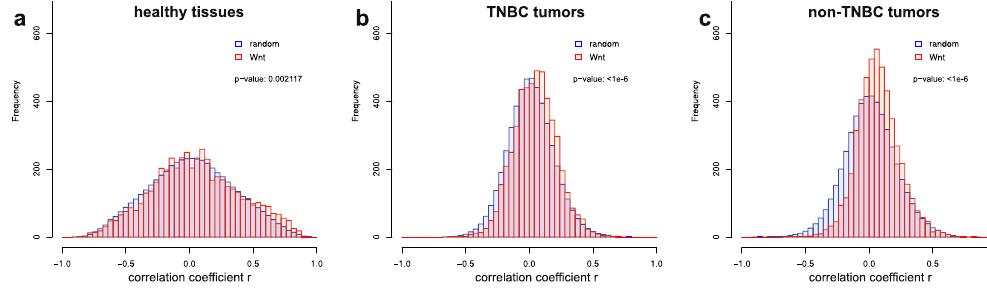
Figure 2. Distribution of the correlation coefficiets for the Wnt genes overlayed on average distribution of correlation coefficients in 500 random genes set in healthy tissues ( a ); TNBC ( b ) or non-TNBC ( c ) tumors. Pathway-related genes show significantly higher numbers of positive strong correlations as compared to the random genes in the healthy breast tissue, while gene co-regulation is dramatically lost in cancer both for random genes and Wnt pathway gene sets. The pathway distributions are narrower and more right-shifted as compared to average random set. P values are given from Kolmogorov-Smirnov test indicating unequality of